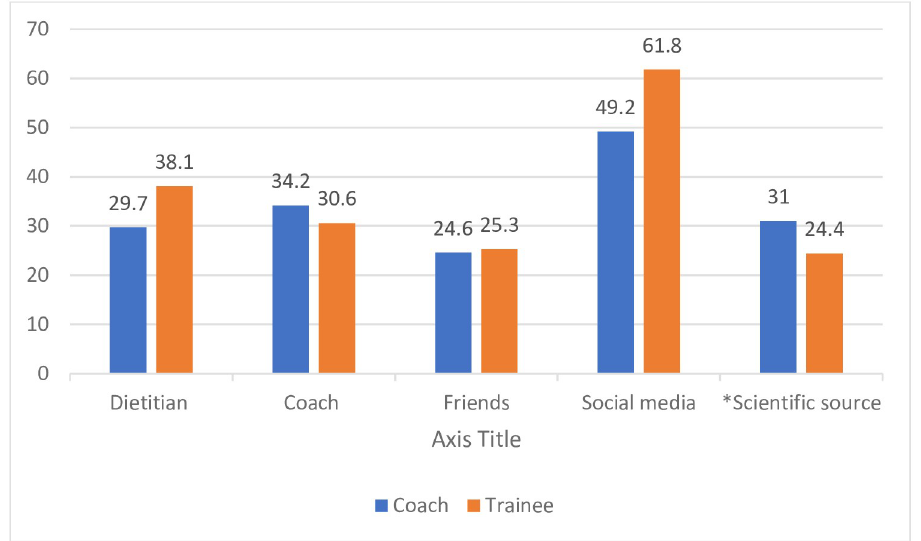
Fig 2. The percentage of the Jordanian athletes who say they use information sources for nutrition-related issues. � Scientific information includes the formal scientific webpages, published research, published books, and